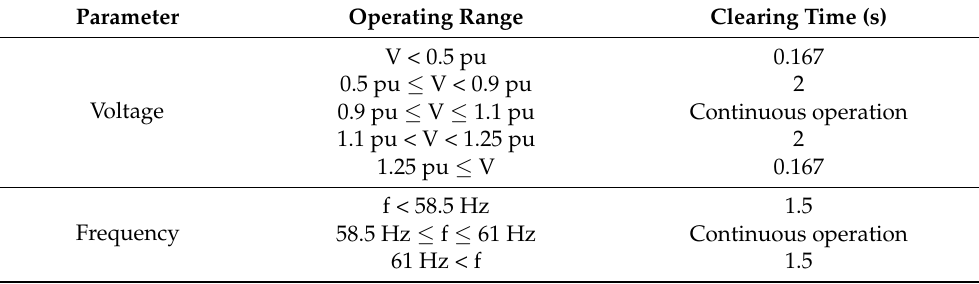
Table 1. Voltage and frequency regulation for distributed energy resources (DERs) interconnection in Deokjeok